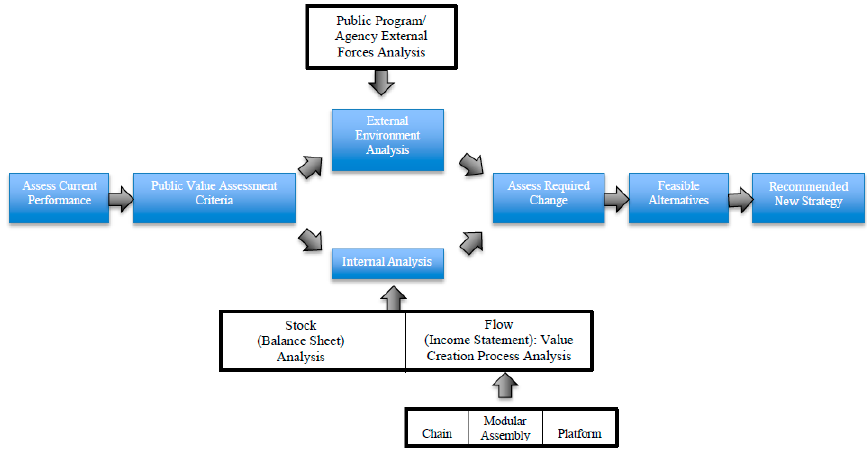
Figure 1. Public Agency Strategic Analysis Framework.